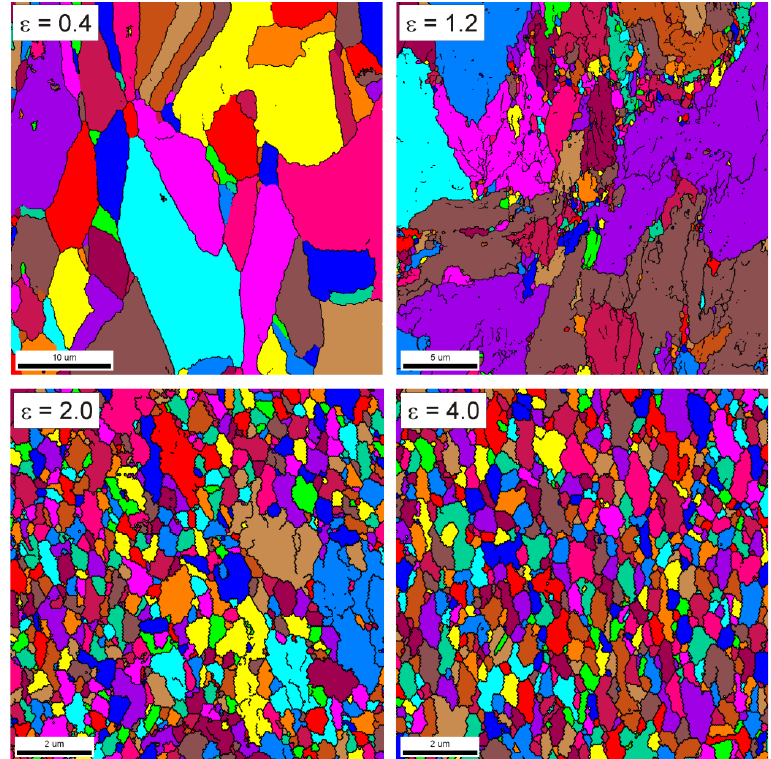
Figure 10. Deformation microstructures (unique grain color mapping) developed in a 304-type stainless steel during multiple forging to indicated total strains at 973 K [70].